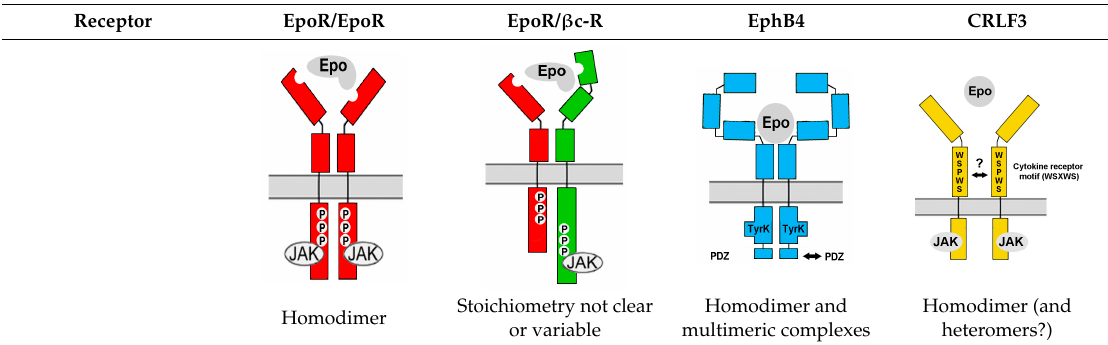
Table 1. Protective functions of classical EpoR and alternative Epo-receptors.